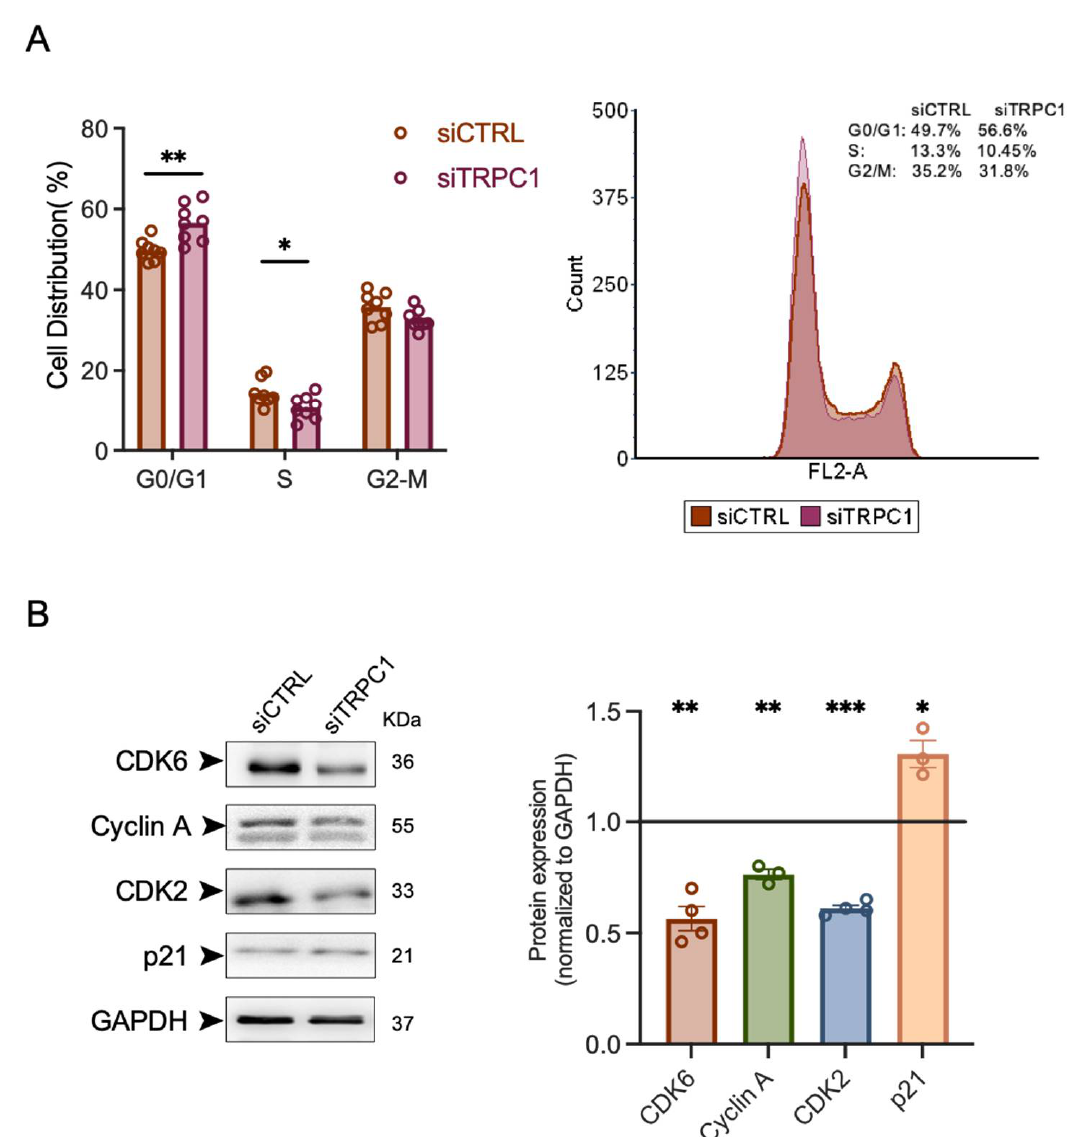
Figure 4. The knockdown of TRPC1 arrests PANC-1 cells in G1/S phases, decreases the expression of CDK6, 2, Cyclin A, and increases the expression of p21 CIP1 . ( A ) Quantification of cell cycle analysis representing the percentage of cells in each cell cycle phase of both transfected PANC-1 cells with either siCTRL or siTRPC1 (left panel) and representative data from FACS acquisition (generated with FCS Express 7) (right panel) ( n = 4). ( B ) Western blot analysis of relevant cyclin-dependent kinase complexes and cyclins and their inhibitor p21 CIP1 (left panel). Quantification of western blot analysis representing the expression of proteins in siTRPC1 lysates compared to siCTRL lysates (right panel) ( n = 3–4). Welch’s correction t-test was used to determine the significant difference between siCTRL and siTRPC1. *, ** and *** indicate p < 0.05, 0.01 and 0.001,